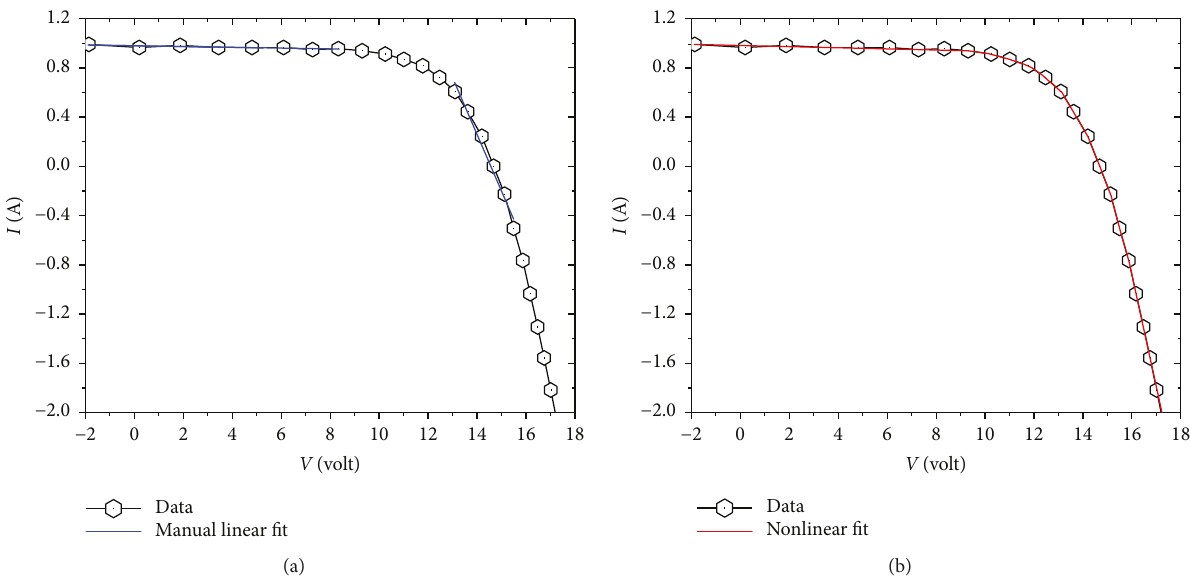
Figure 3: Curve fi t on a silicon solar cell (R.T.C France) using the manual method (a) and the nonlinear curve fi t using the Shockley equation (b). Table 1: Comparison of manual and Shockley nonlinear fi t on any solar cell. The Δ is from reference while χ 2 is from this work.